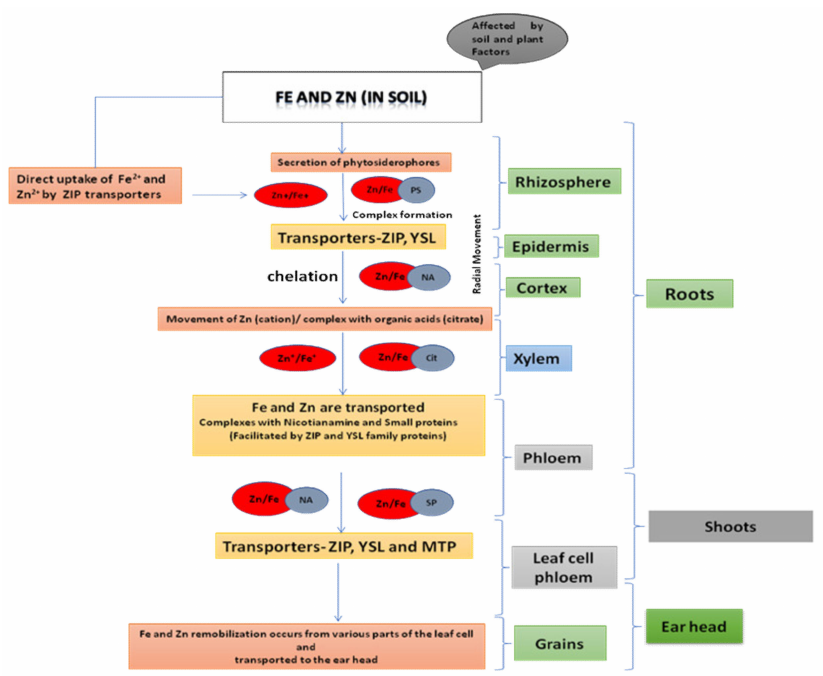
Figure 2. Molecular mechanism involved in the iron and zinc movement from soil to seed in the